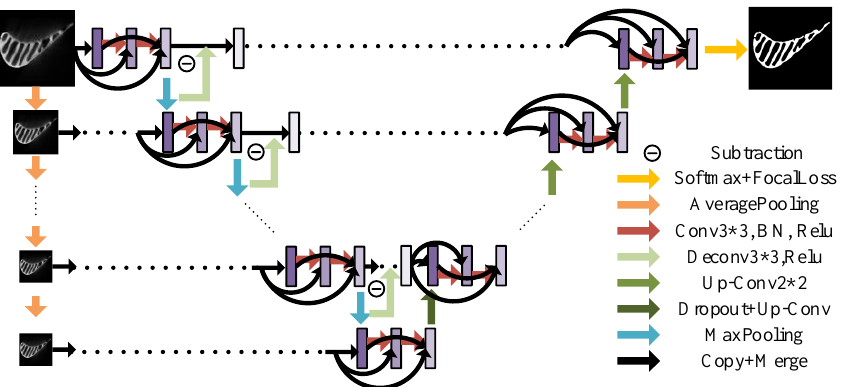
Figure 4. Structure of the enhanced U-net.